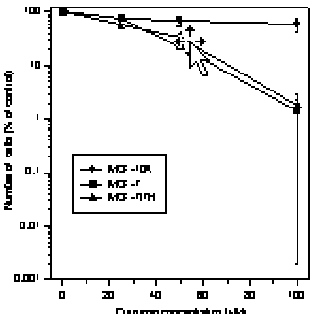
Fig. 1. Curcumin cytotoxicity of human mammary epithelial (MCF-10A) and breast carcinoma (MCF-7 and MCF- 7/TH) cell lines.